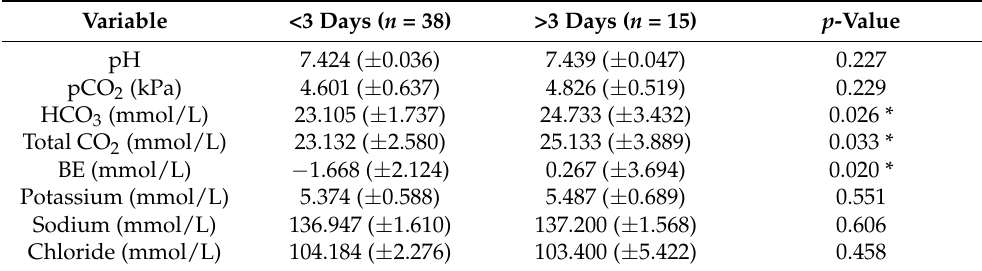
Table 4. Influence of the duration of vomiting on acid-base status in the control